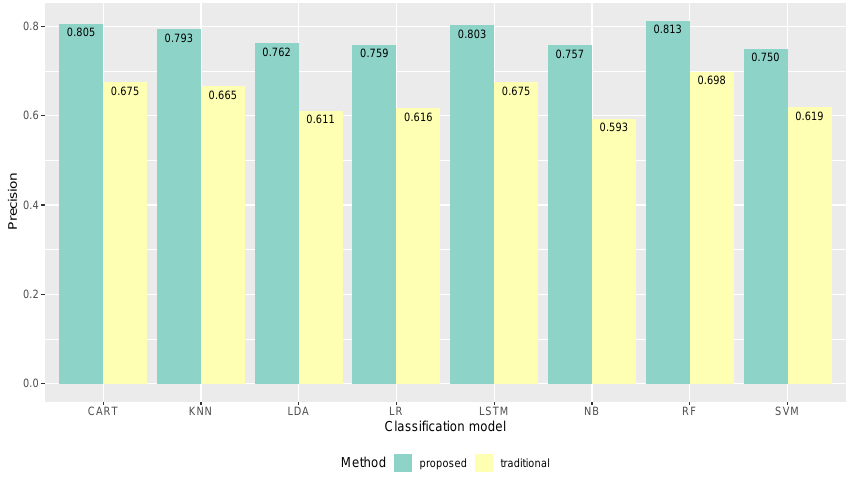
Figure 11. The precision performance results of several machine learning models.